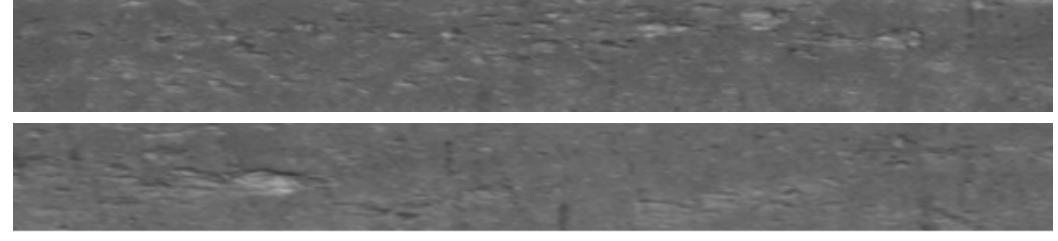
Figure 14. Unrecognized roll marks.